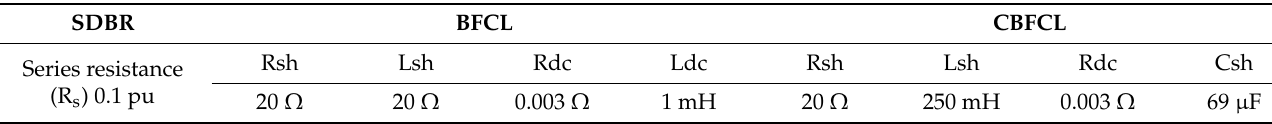
Table 2. Parameters of the fault current